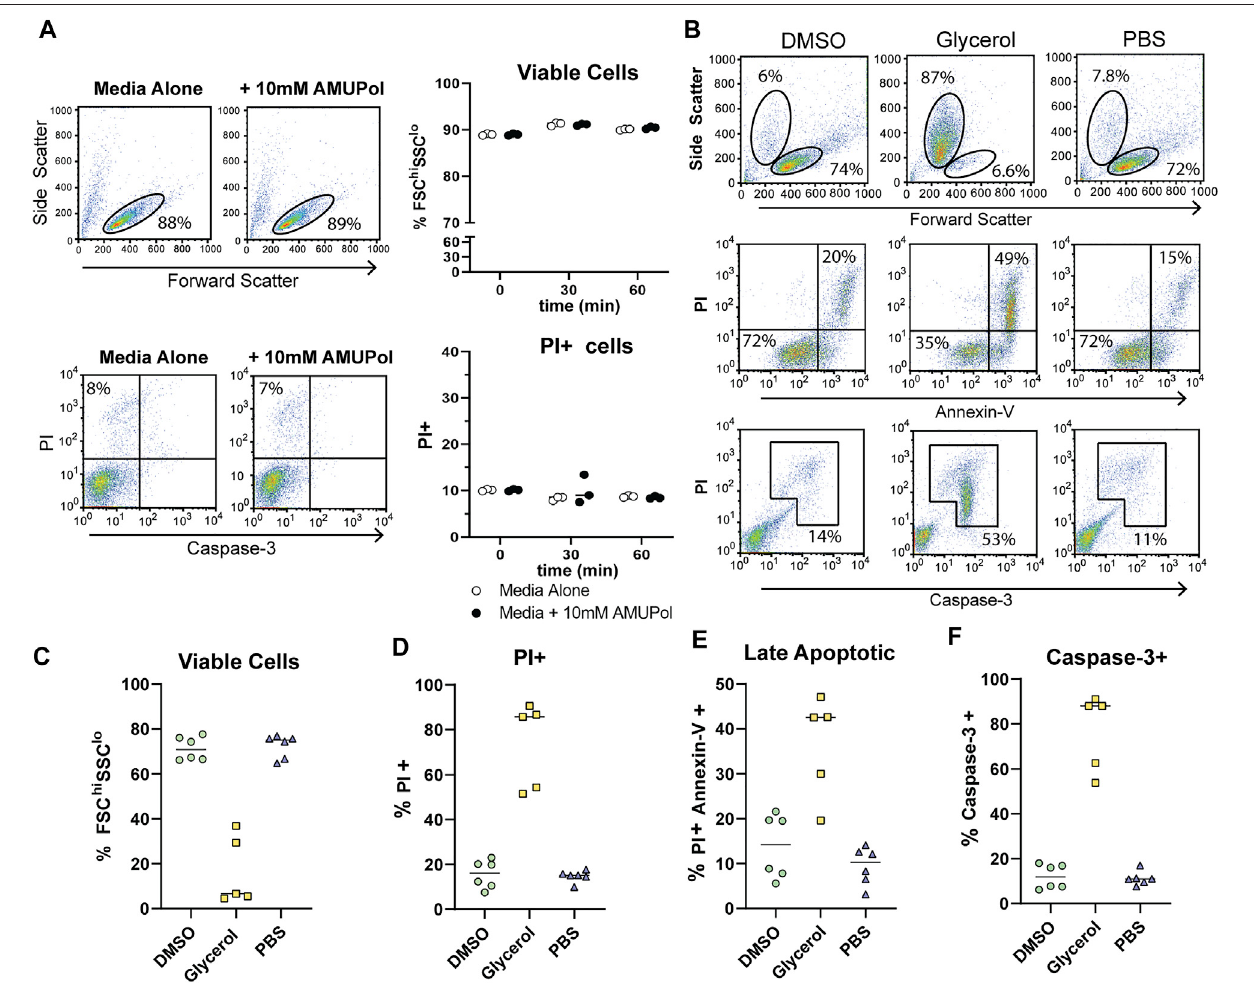
FIGURE 1 | Cellular integrity and apoptosis in the presence of AMUPol and cryoprotecting agents. (A) Flow cytometric analysis of AMUPol treated cells. Flow cytometryplotsarerepresentativeofthreesamplestreatedfor1 h.Percentagesaredeterminedbasedonthegatesshownintheplots.Dataisfromasingleexperiment. (B) Representative fl ow cytometry plots of the effect of cryopreserving agents (in the absence of radical) on cell phenotypes and apoptosis. Percentages indicate the proportion of total cells within the indicated gates. Gates are set based on control (PBS treated) fl uorescence intensities. All plots show total events. (C) Quanti fi cation of viable cells determined by FSC hi SSC lo cells (top panels in B). (D) Quanti fi cation of PI positive cells as determined by gates shown in Supplementary Figure S1 . (E) Quanti fi cation oflateapoptotic cells determined bypositivestainingforPIand Annexin-Vasshown intheupper rightquadrantofthemiddle panels of (B, F) Quanti fi cation of caspase-3 positive cells determined by the gate shown in the bottom panels of (B). Data is pooled from 2 independent